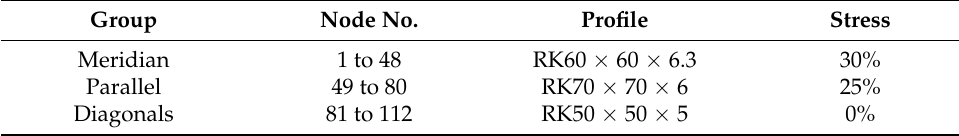
Table 2. Cross-sections of individual bar groups and the maximum bar